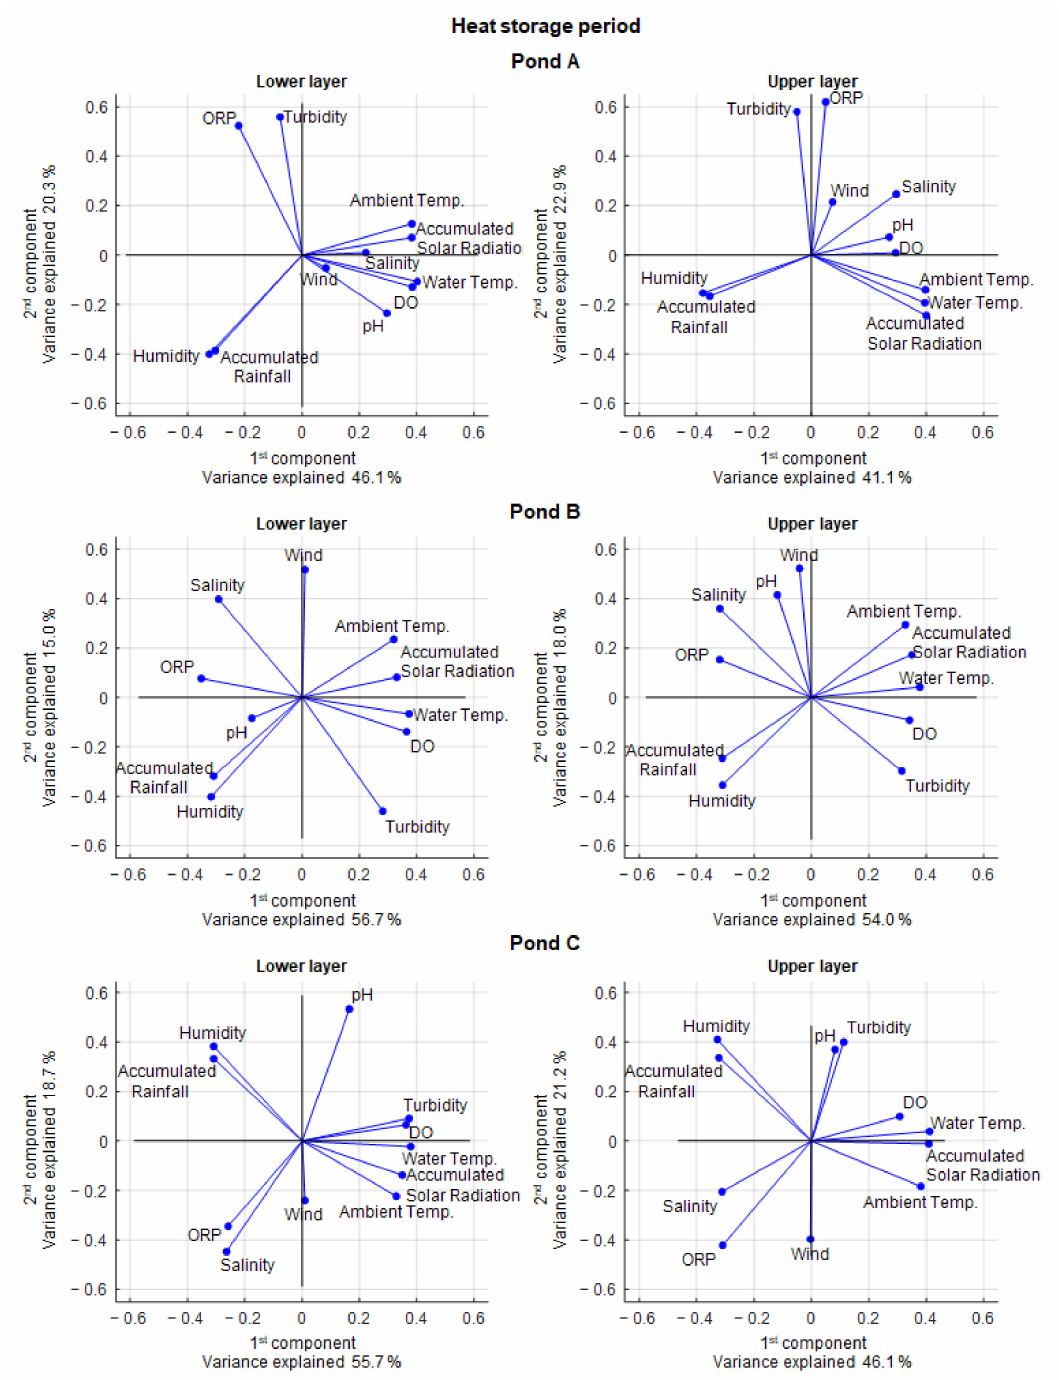
Figure 15. Biplot of PCA scores for the heat storage period. The mechanism that changed the turbidity tendency between the lower and upper layers in Pond C could be considered as being due to a halocline associated with the forma- tion of three density-stratified layers induced by rainfall. As mentioned in the previous section, if the three-layer salinity stratification was composed of a lower high-salinity layer, a halocline layer, and an upper low-salinity layer, then the halocline layer would be non-convective and heat storage would progress in the lower high-salinity layer. The mech- anism of heat storage in the lower high-salinity layer conveys an insulating effect of heat transfer, due to non-convection in the halocline. As with the mechanism of heat